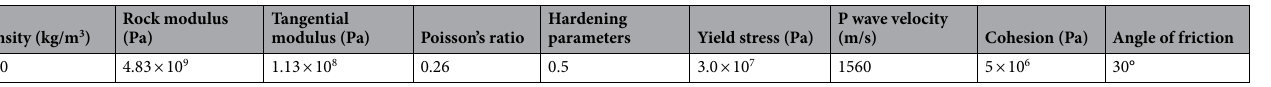
Table 1. Surrounding rock physics parameters.